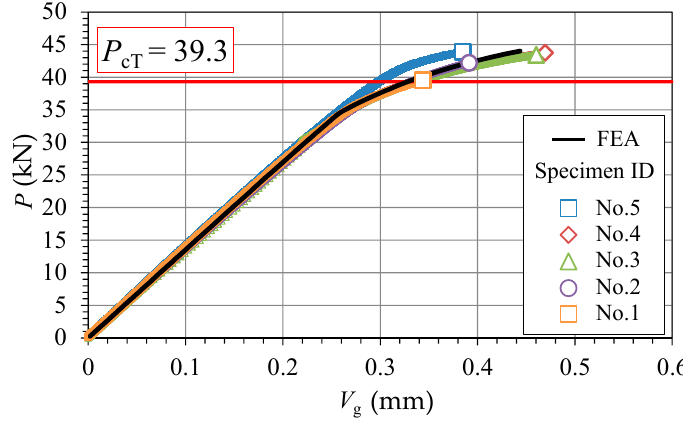
Figure 13. P – V g diagram with CRS (S45C, SE(B) specimen, W = 46 mm, B / W = 0.5, − 10 °C). The open symbols represent the experimental results, and the solid line is the EP-FEA result.